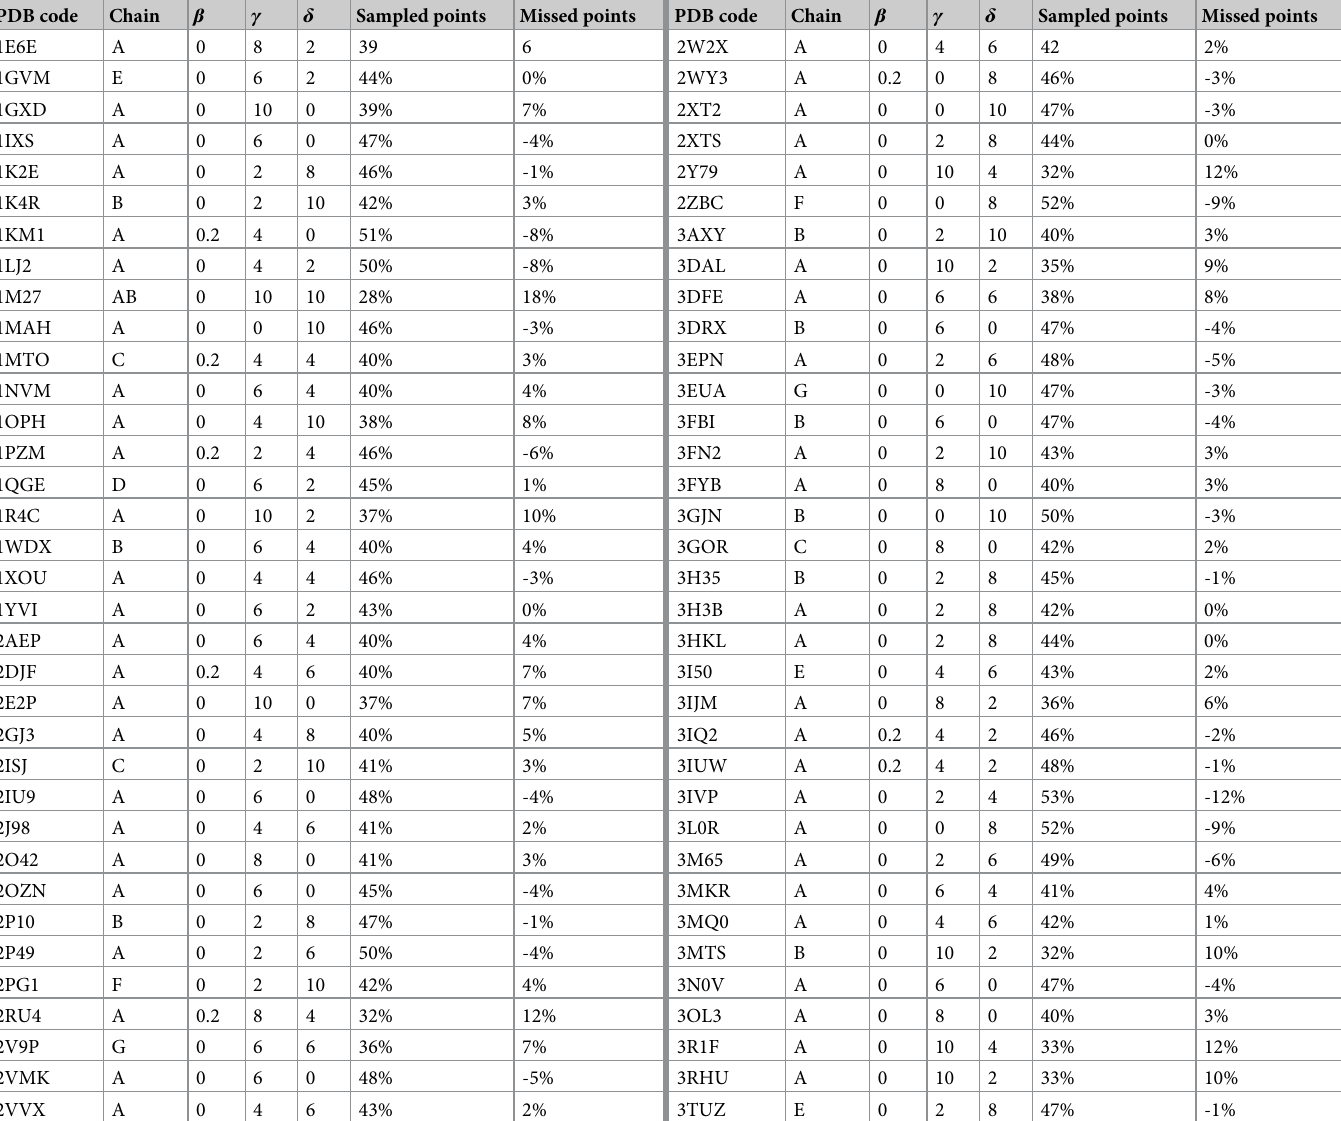
Table 2. Comparison between the best and the average set of parameters for 70 proteins.